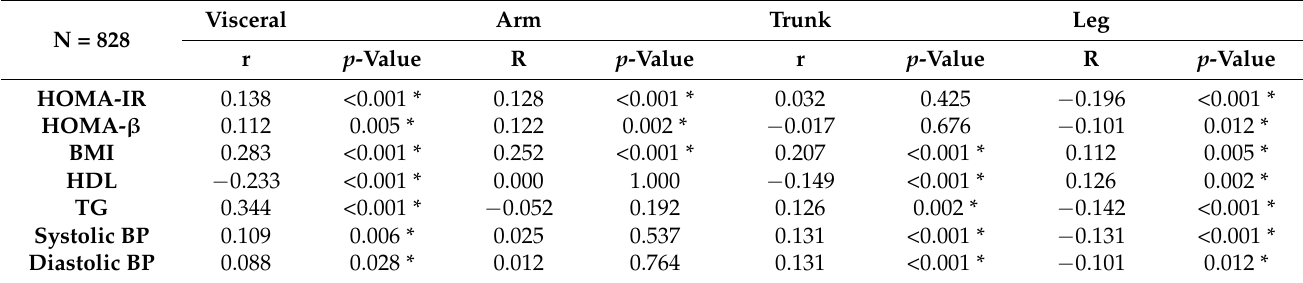
Table 8. Associations between regional adiposity and metabolic characteristics in menopausal